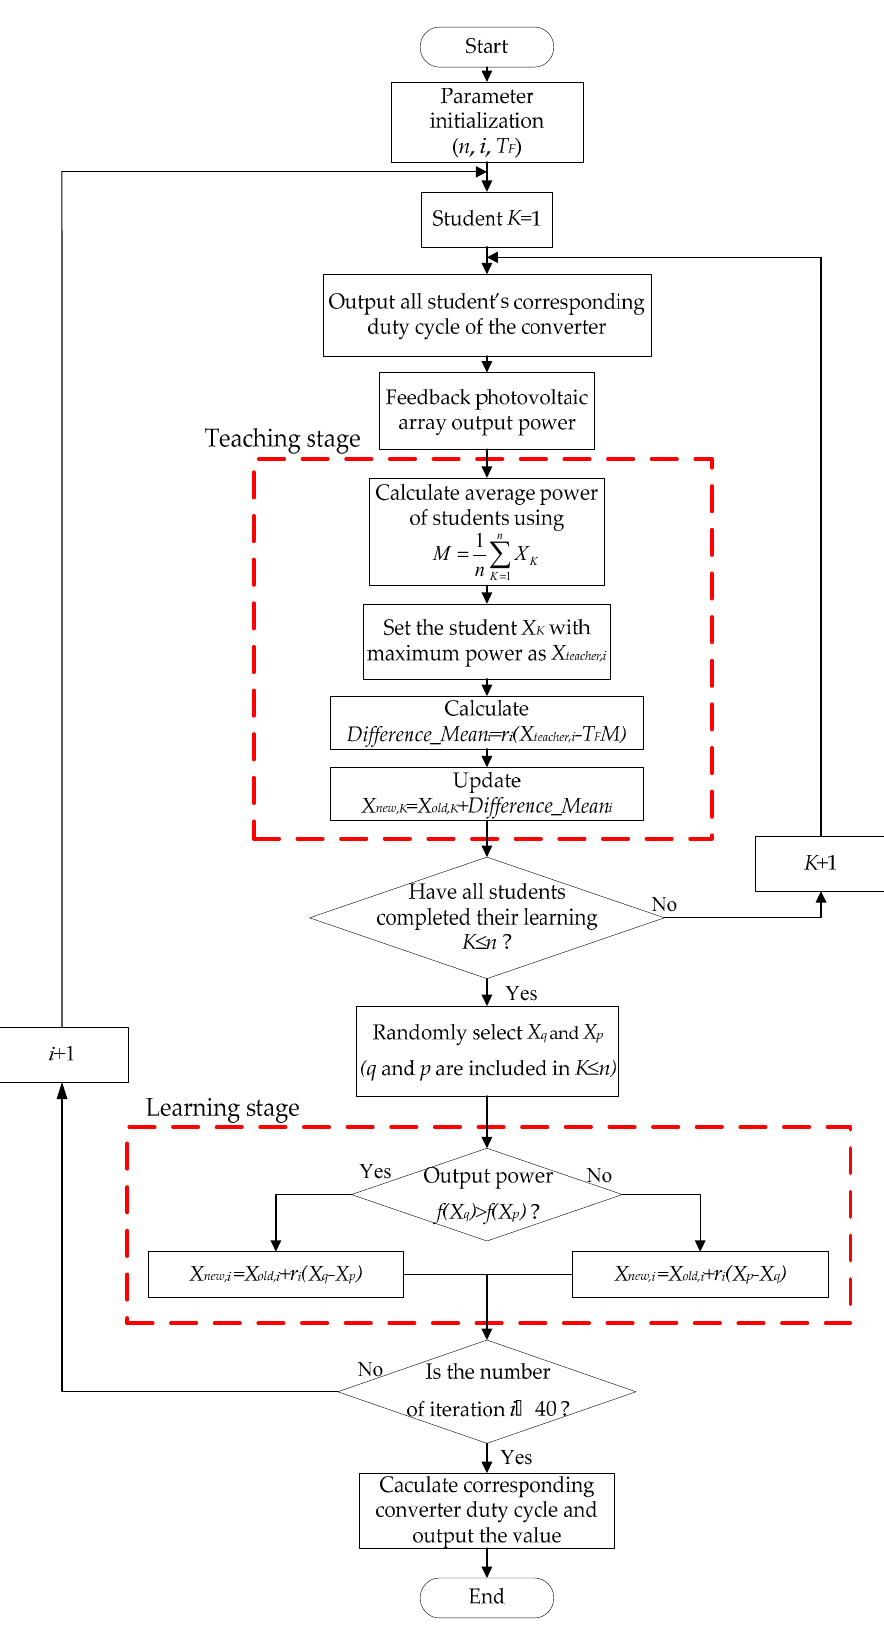
Figure 5. Flow chart of the proposed teaching learning based optimization (TLBO) method applied to the photovoltaic module array for maximum power point tracking.